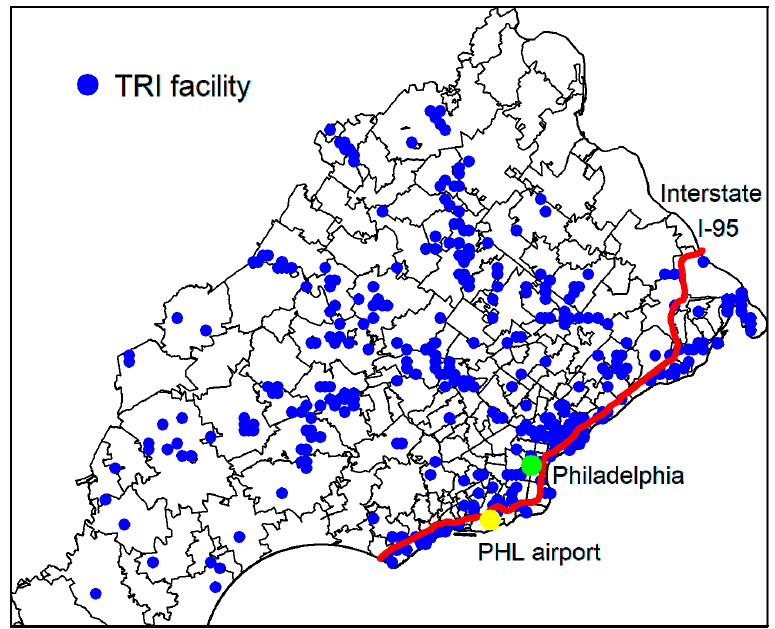
Figure 2. Locations of TRI facilities, Philadelphia (green point), Philadelphia International (PHL) Airport (yellow point), and Interstate I-95 highway (in red) in the study area.